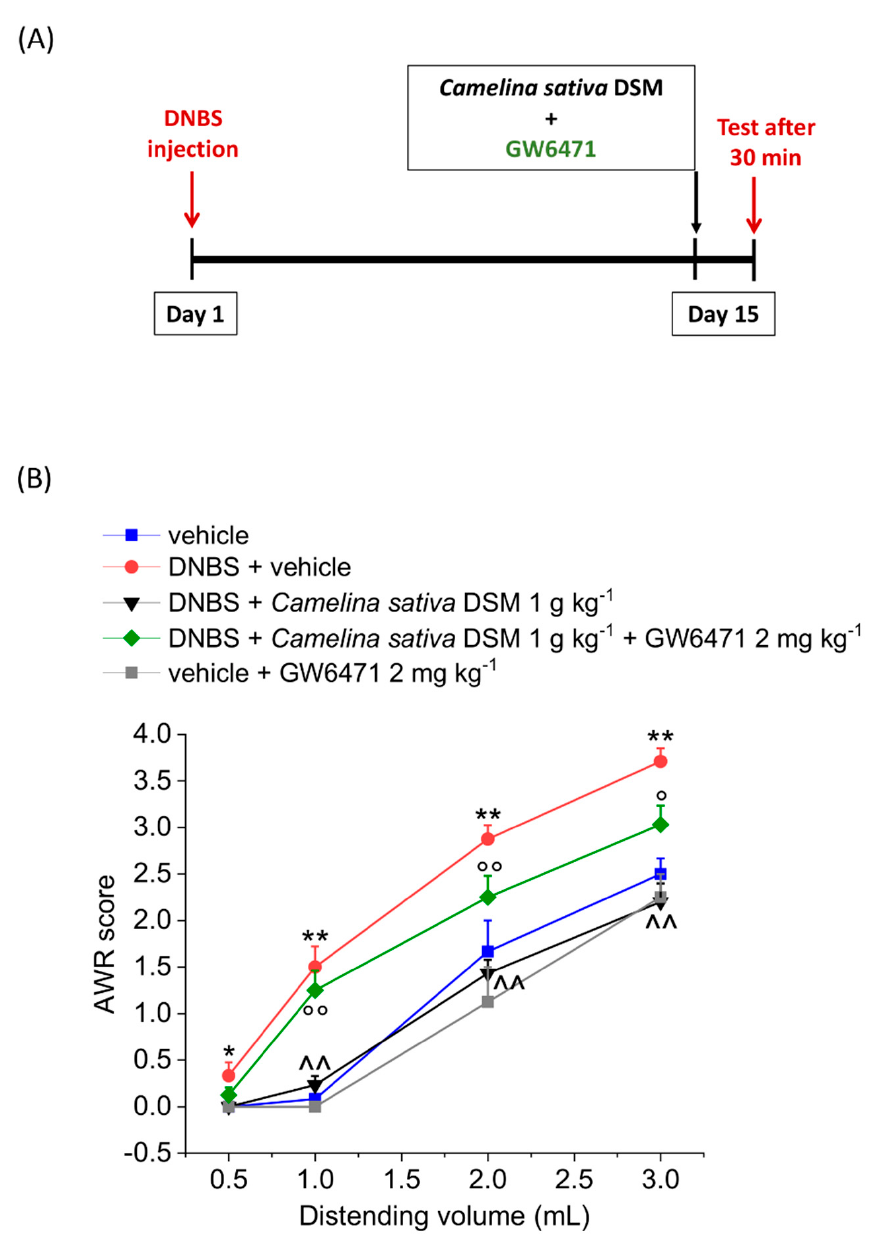
Figure 3. The contribution of PPAR- α receptor activation to the acute pain-relieving effect of Camelina sativa DSM. ( A ) Experimental scheme: the behavioural test was performed 30 min after the oral administration of the Camelina sativa DSM (0.1–1 g kg − 1 p.o.). ( B ) Visceral sensitivity was assessed in animals by measuring the extent of the abdominal withdrawal response (AWR) to colorectal distension, carried out by applying an increasing distending stimulus on the colon walls (0.5–3 mL). The PPAR- α receptor antagonist GW6471 (2 mg kg − 1 ) was intraperitoneally administered in concomitance with Camelina sativa DSM (1 g kg − 1 ), and the test was performed after 30 min. Each value represents the mean ± SEM of six animals per group. * p < 0.05 and ** p < 0.01 vs. vehicle. ^^ p < 0.01 vs. DNBS + vehicle. ° p < 0.05 and °° p < 0.01 vs. DNBS + Camelina sativa DSM.